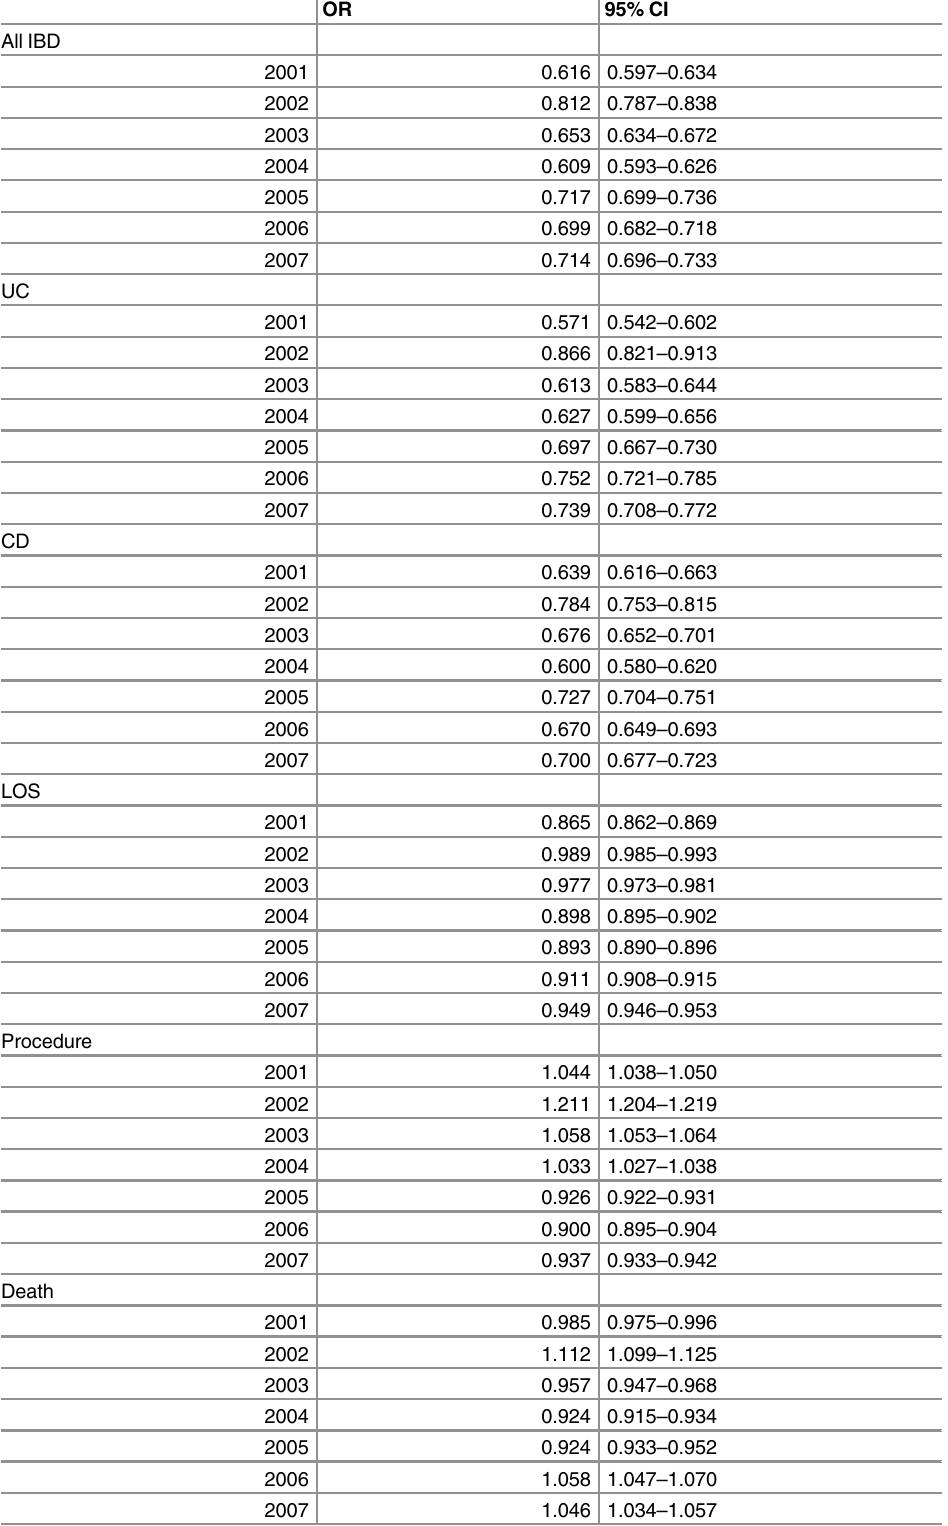
Table 3. Multivariate analysis comparing south versus north. Variables included in the multivariate anal- ysis included race, age, and payer status. OR 95% CI All